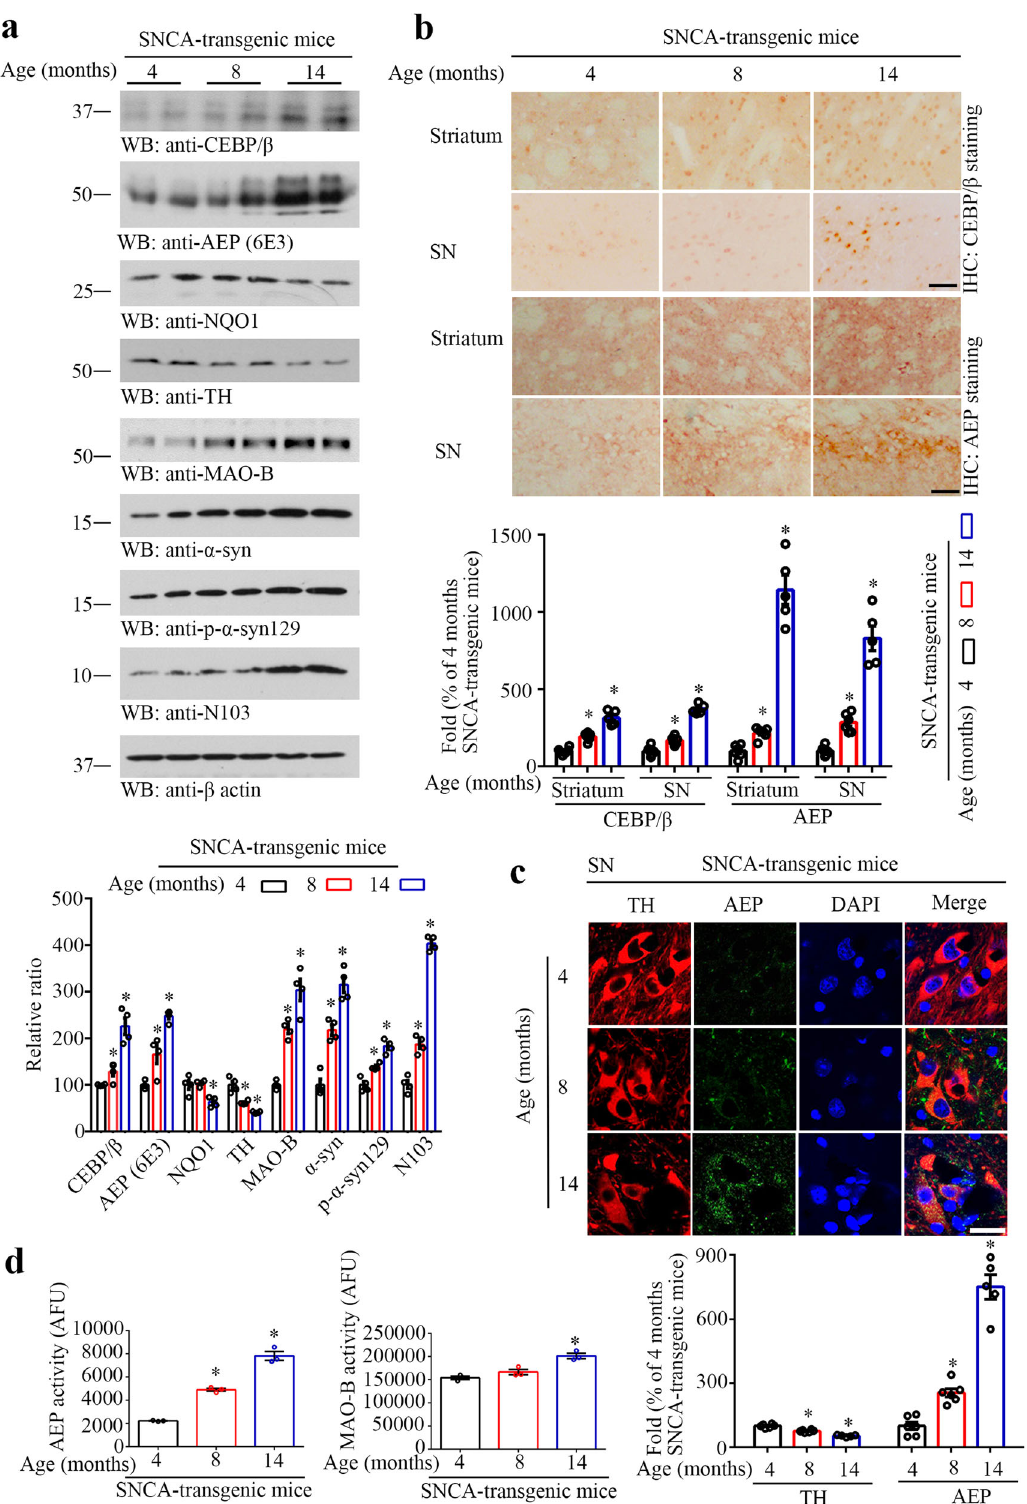
Fig. 1 C/EBP β /AEP axis is age-dependently activated in human α -SNCA transgenic mice. a Western blot showing C/EBP β , AEP, NQO1, TH, MAO-B, and α -Syn expressing and processing in the brain of the α -SNCA transgenic mouse during aging. Quanti fi cation of western blotting ( n = 4 per group, * P < 0.05 vs 4 months old α -SNCA transgenic mouse, one-way ANOVA). b Immunohistochemistry and the quanti fi cation of C/ EBP β and delta-secretase in the striatum and SN ( n = 5 – 6 per group, * P < 0.05 vs 4 months old α -SNCA transgenic mouse, one-way ANOVA). Scale bar, 50 μ m. Immuno fl uorescent staining and the quanti fi cation ( c ) of TH and AEP in SN (mean ± s.e.m.; n = 5 – 6 per group, * P < 0.05 vs 4 months old α -SNCA transgenic mouse, one-way ANOVA). Scale bar, 20 μ m. d AEP and MAO-B activity assay in the SN samples (mean ± s.e.m.; n = 3 per group, * P < 0.05 vs 4 months old α -SNCA transgenic mouse, one-way